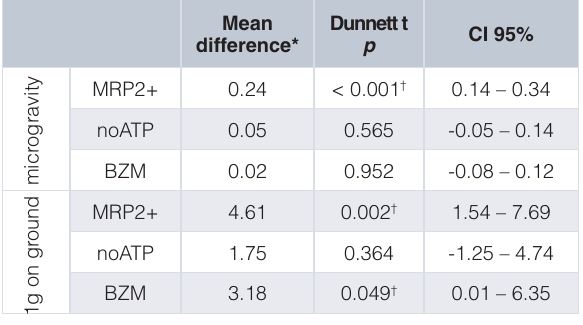
Table 2. Net E17 β G transport